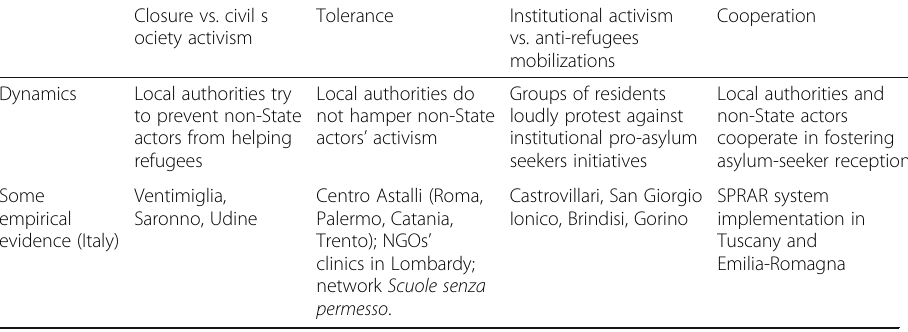
Table 3 Typology of the different relations between state and non-State actors at the local